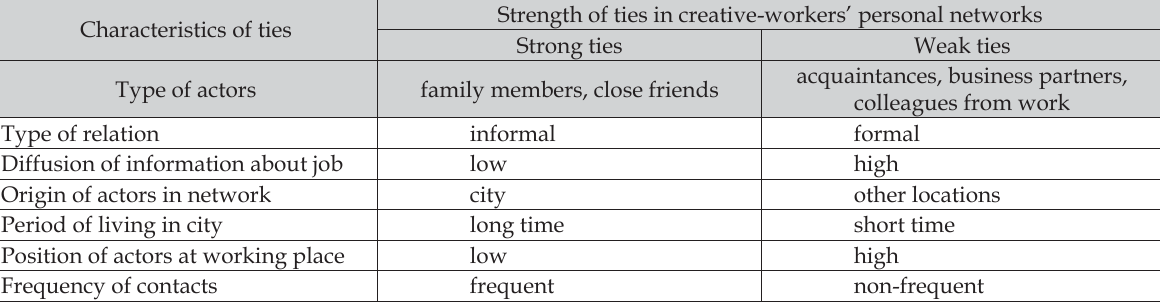
Table 1. Characteristics of ties in personal networks of creative-sector